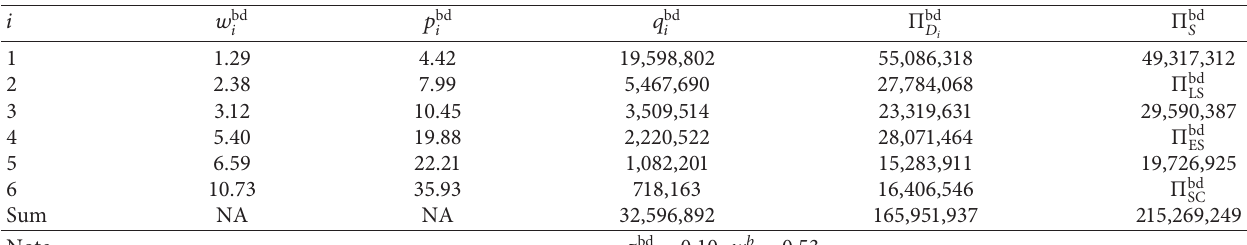
Table 6: Numerical analysis results of equilibrium decision with partial